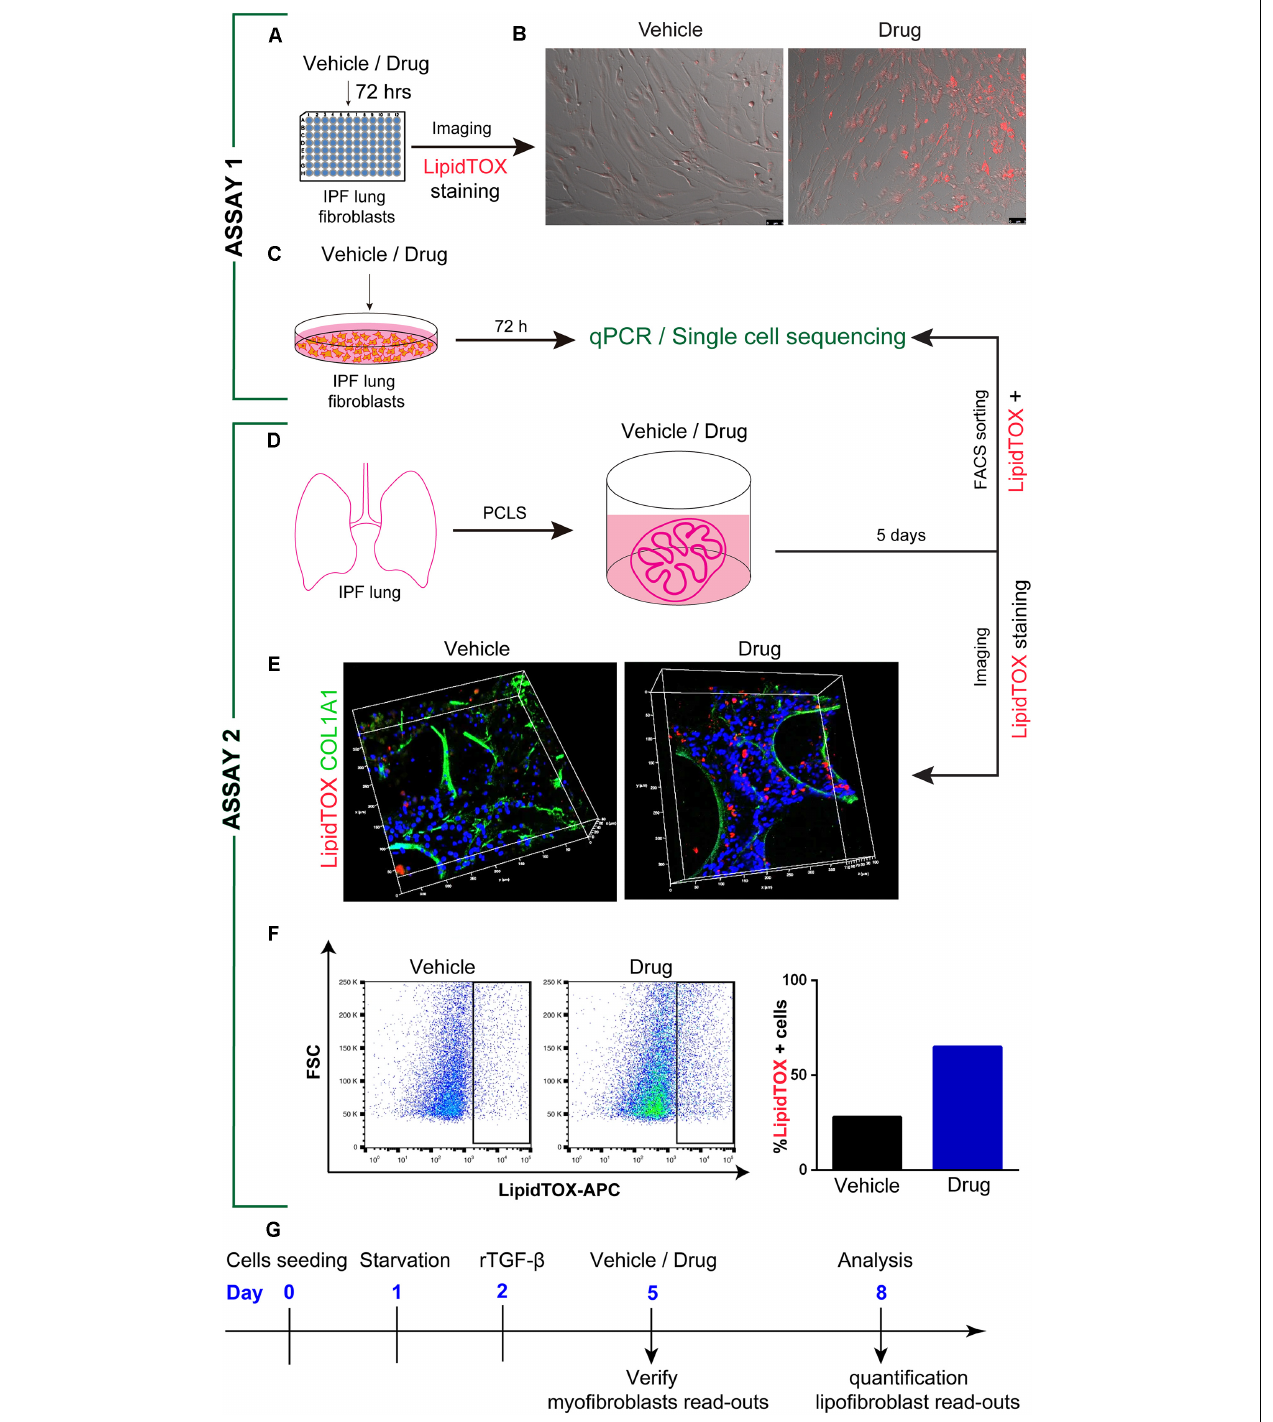
FIGURE 2 | In vitro drug screening models in idiopathic pulmonary fibrosis. (A) Experimental set-up, where primary IPF lung fibroblasts are treated with drugs or vehicle in a 96 well plate. (B) Time-lapse imaging with presence of LipidTOX dye to visualize lipid drops for 72 h. (C) Treatment of primary IPF lung fibroblasts with drugs or vehicle for 72 h and gene analysis by qPCR or single-cell sequencing. (D) PCLS preparation from fresh IPF lung explants and treatment of PCLS with drugs or vehicle for 5 days, FACS-sorting of LipidTOX positive cells, and analysis of genes by qPCR or single-cell sequencing. (E) Confocal images of PCLS after 5 days treatment and staining with LipidTOX dye and anti-Collagen1 antibody. (F) FACS-based analysis and quantification for vehicle and drug treated PCLS or IPF lung fibroblasts. (G) Timeline for assay 1 (Figure 2 adapted from Kheirollahi et al., 2019). Scale bars: (B) 5 µ m; (E) 400 µ m, 400 µ m, 100 µ m (XYZ-axis).